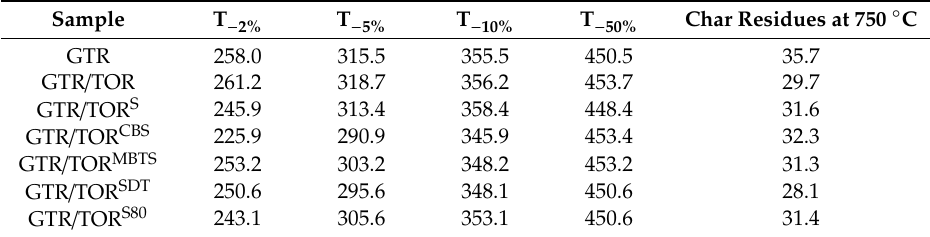
Table 6. Thermal decomposition characteristics of tested samples estimated from TGA